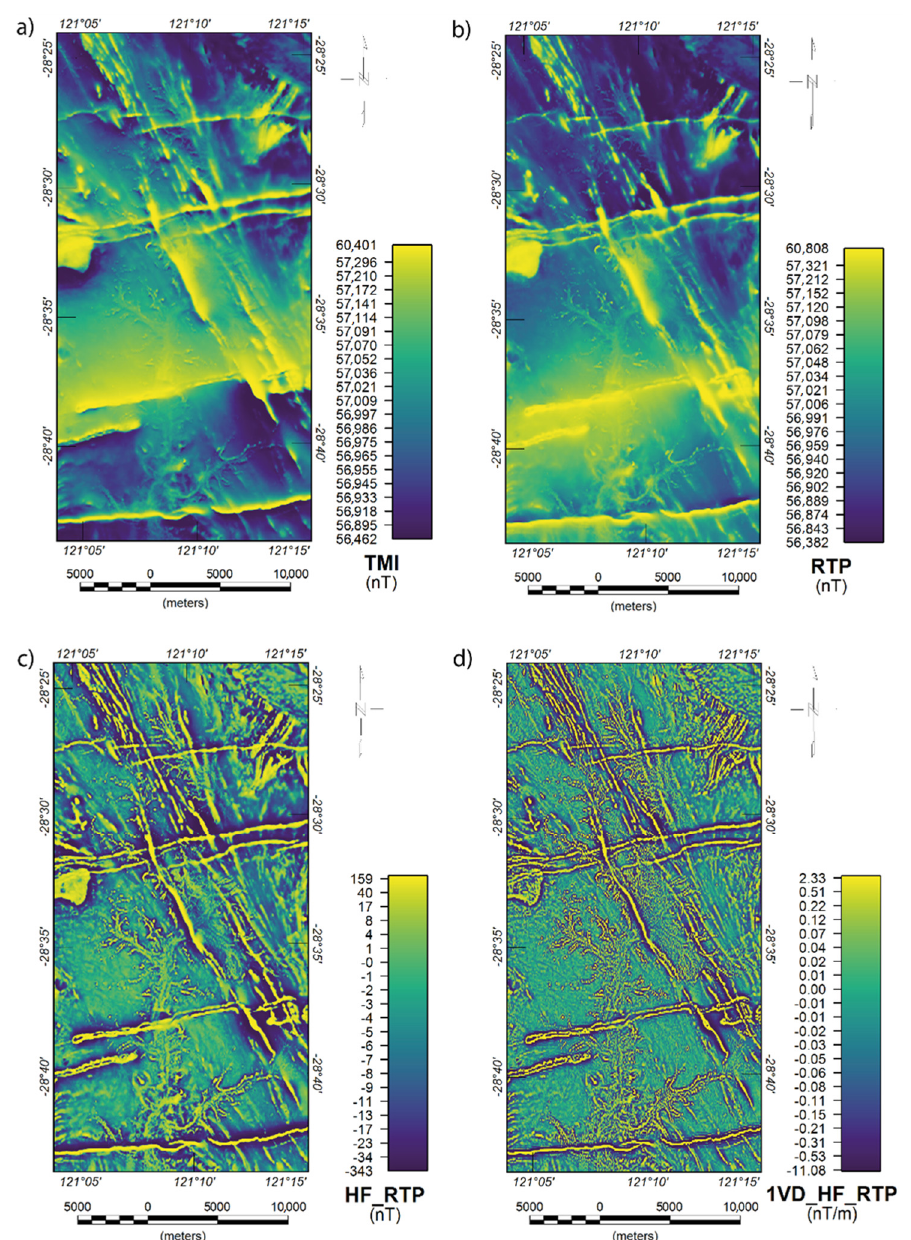
Figure 3. Pre-processed high-resolution aeromagnetic data in the Tarmoola area. ( a ) Total magnetic intensity (TMI) grid. ( b ) Reduced to pole (RTP) grid. ( c ) Accentuated high frequency (HF) content of the RTP grid. ( d ) First vertical derivative (1VD) of the HF grid. All grids are histogram-equalised and presented in a perceptually uniform colour scale.